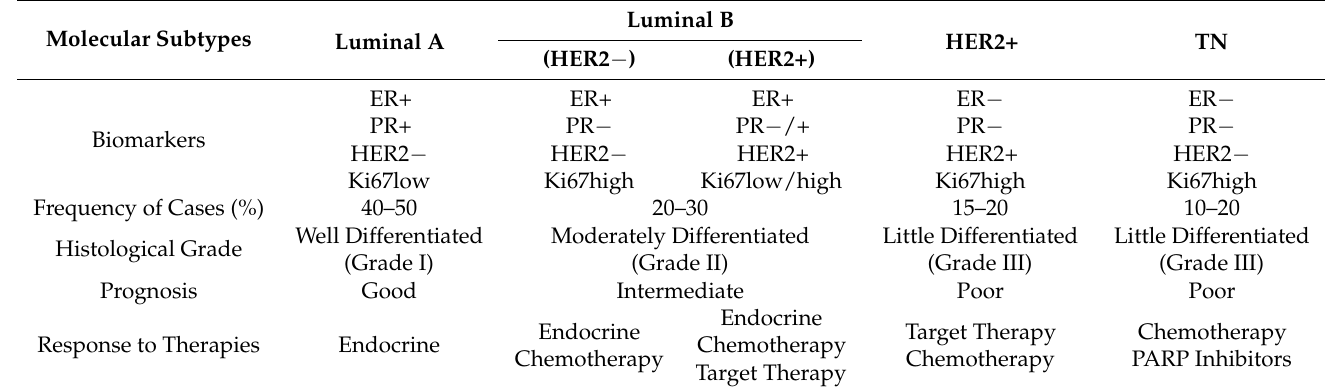
Table 1. Descriptive table of the molecular classification of breast cancer including the biomarkers, grade, prognoses, treatment, and frequency of cases. From do Nascimento RG, Otoni KM, “Histologi- cal and molecular classification of breast cancer: what do we know.” Mastology . 2020;30:e20200024, http://creativecommons.org/licences/by/4.0/, accessed on 6 November 2022